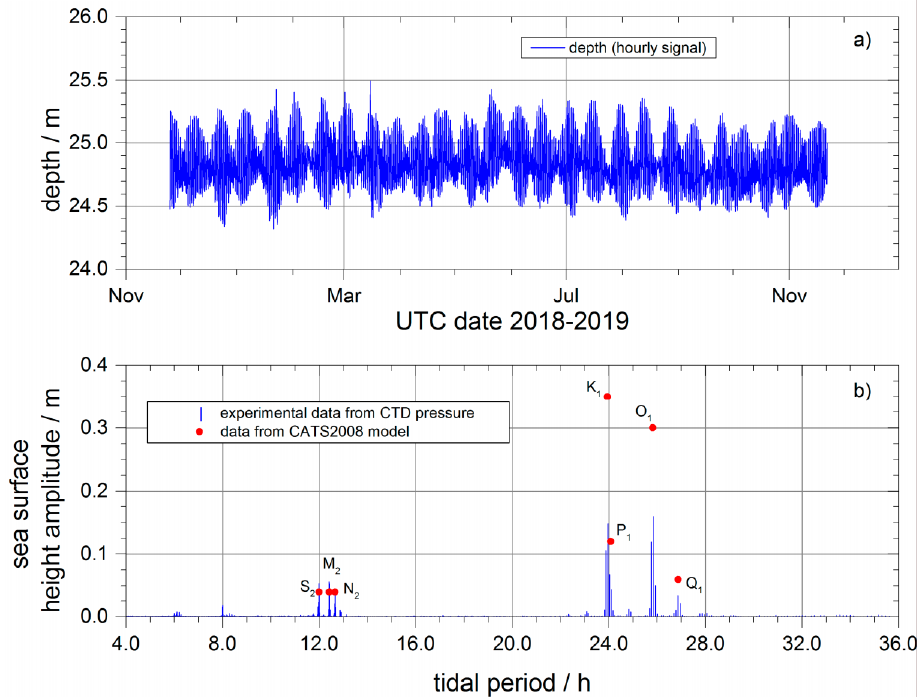
Figure 5. Tidal measures by the CTD pressure sensor. ( a ) Sea surface height behavior vs. time. ( b ) FFT analysis: principal tidal constituents and their period vs. values reported in literature (red dots). S 2 : principal solar semidiurnal; M 2 : principal lunar semidiurnal; N 2 : larger lunar elliptic semidiurnal; K 1 : principal lunisolar diurnal; P 1 : principal solar diurnal; O1: principal lunar diurnal; Q 1 : larger lunar